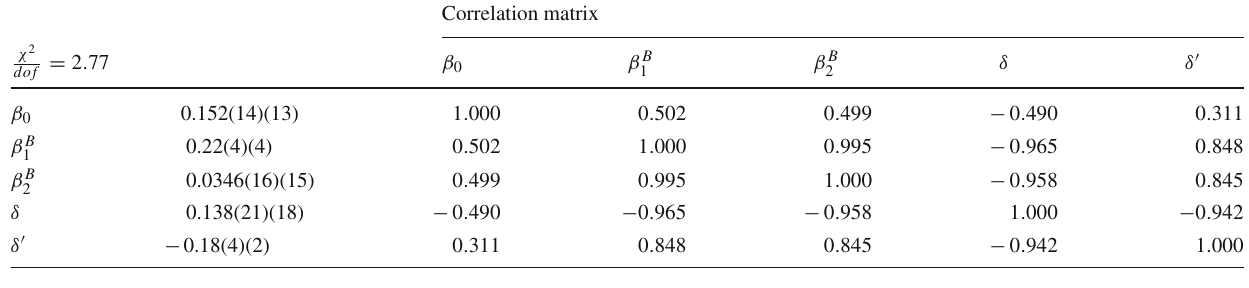
uncertainties of the LECs quoted in Ref. [56] that enter in the definition of the chiral amplitudes. The LECs β 0 and β B of GeV (GeV − 1 ) Correlation matrix